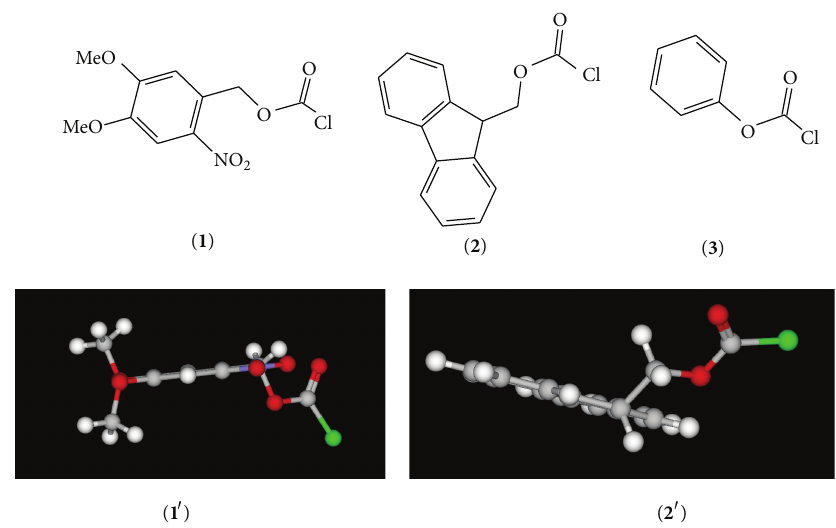
Figure 1: Molecular structures of 4,5-dimethoxy-2-nitrobenzyl chloroformate (NVOC-Cl, 1 ), 9-fluorenylmethyl chloroformate (FMOC-Cl, 2 ), and phenyl chloroformate (PhOCOCl, 3 ). The 3D structures for 4,5-dimethoxy-2-nitrobenzyl chloroformate ( 1 󸀠 ) and 9-fluorenylmethyl chloroformate ( 2 󸀠 ).